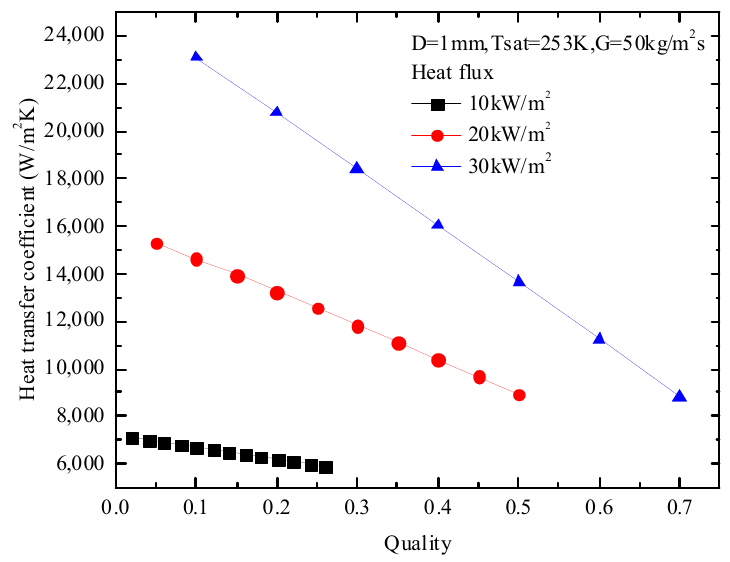
Figure 13. Effect of heat flux on heat transfer coefficient of azeotropic refrigerant.